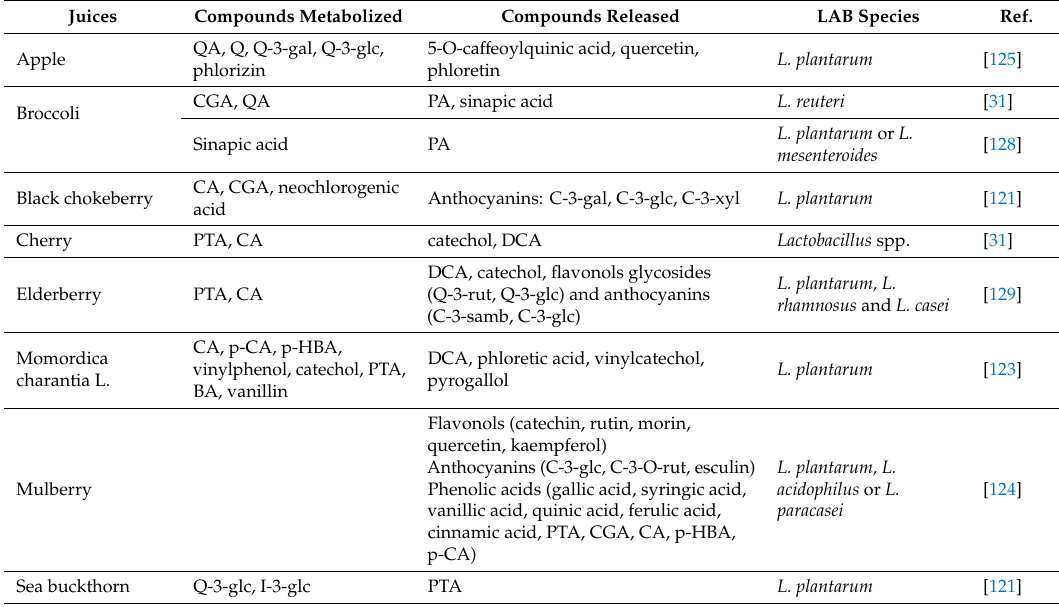
Table 4. Review of the recent studies on changes in polyphenol profile with fermentation of fruit and vegetables by